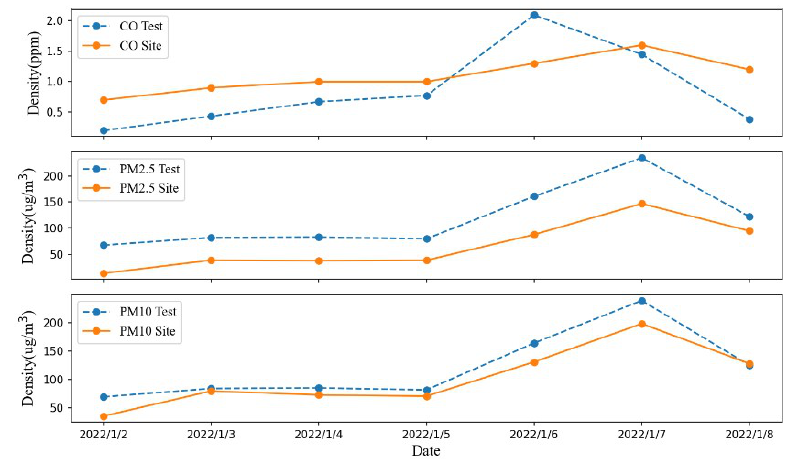
Figure 9. Comparison between the experimental measurement value and the national control station value. The yellow solid line is the station value, and the blue dotted line is the measured value.